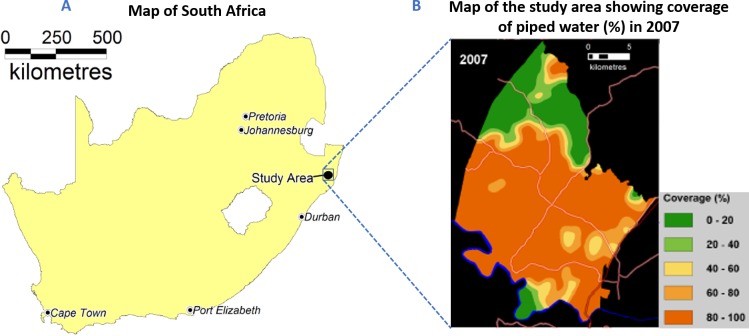
Location of the study area in South Africa.Panel A displays the map of South Africa highlighting the major towns and the location of the study area. Panel B displays the map of the study area showing the major roads and the coverage of piped water (%) in 2007. Community piped water coverage was estimated using the Gaussian kernel methodology (Tanser et al., 2018).